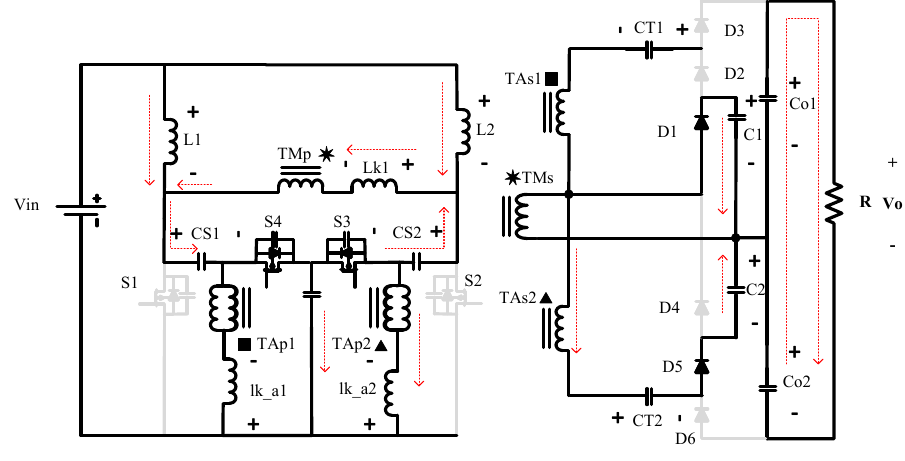
Figure 4. Second switching state.